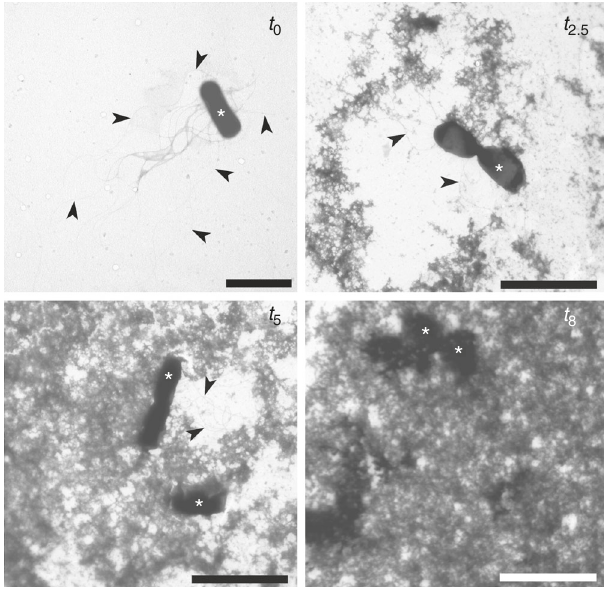
Fig. 1 Development of the B. subtilis wt extracellular